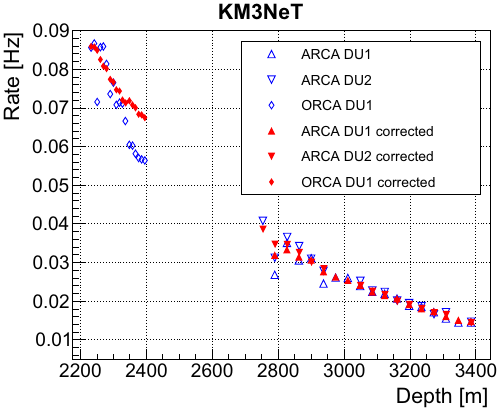
Fig. 8 Multiplicity ≥ 8 coincidence rate of all DOMs as function of depth below the sea level. The coincidence rates for the ARCA2 and ORCA1 detectors are reported as measured (blue points) and after the correction for the PMT photon detection efficiencies (red points). Sta- tistical uncertainties are included and smaller than